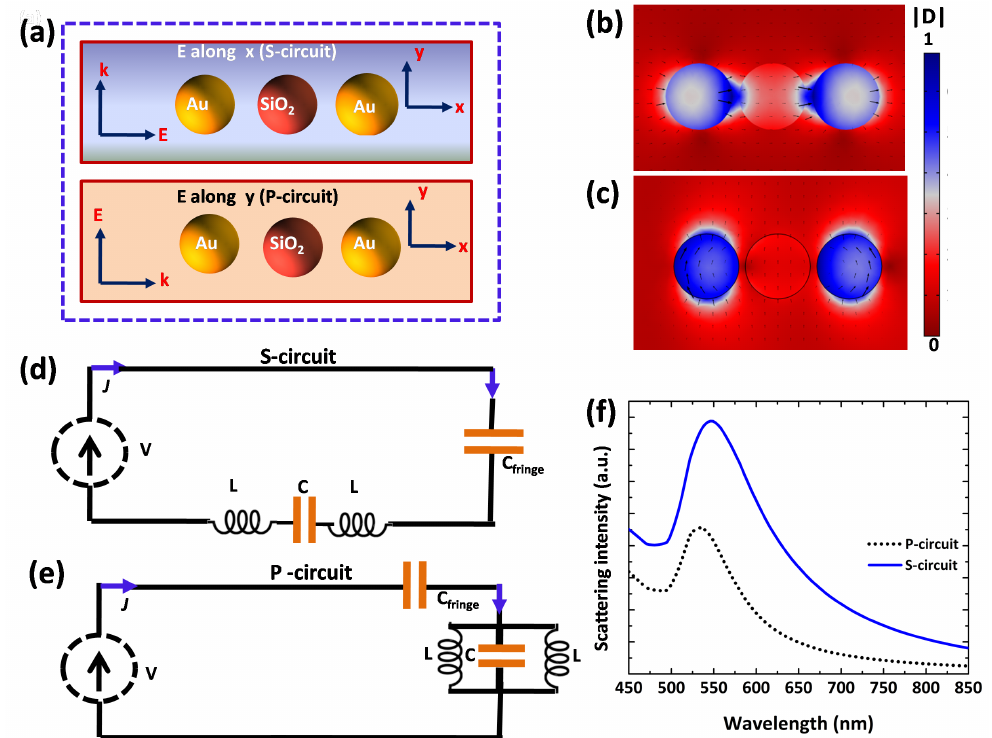
Figure 7. Second and third order lumped nanocircuits. ( a ) A schematic and geometry structure of a three NP trimmer composed of a silica nanosphere sandwiched between two Au nanospheres in air for perpendicular and parallel cases of incidence of light. ( b ) The simulated scattered displacement field measurements for s-polarized light exciting the nanocircuit with the E-field along x and localized field at the plasmonic resonance (547 nm). ( c ) The simulated scattered displacement field for p- polarized light exciting the nanocircuit with the E-field along y and response at the plasmonic resonance (532 nm). ( d,e ) Thevenin nanocircuit models of second order (d, series LC, S-circuit) and third order (i.e., CLC circuit, P-circuit) lumped nanofilters. ( f ) Corresponding Optical spectrum for S-circuit (solid blue line) and P-circuit (black dotted